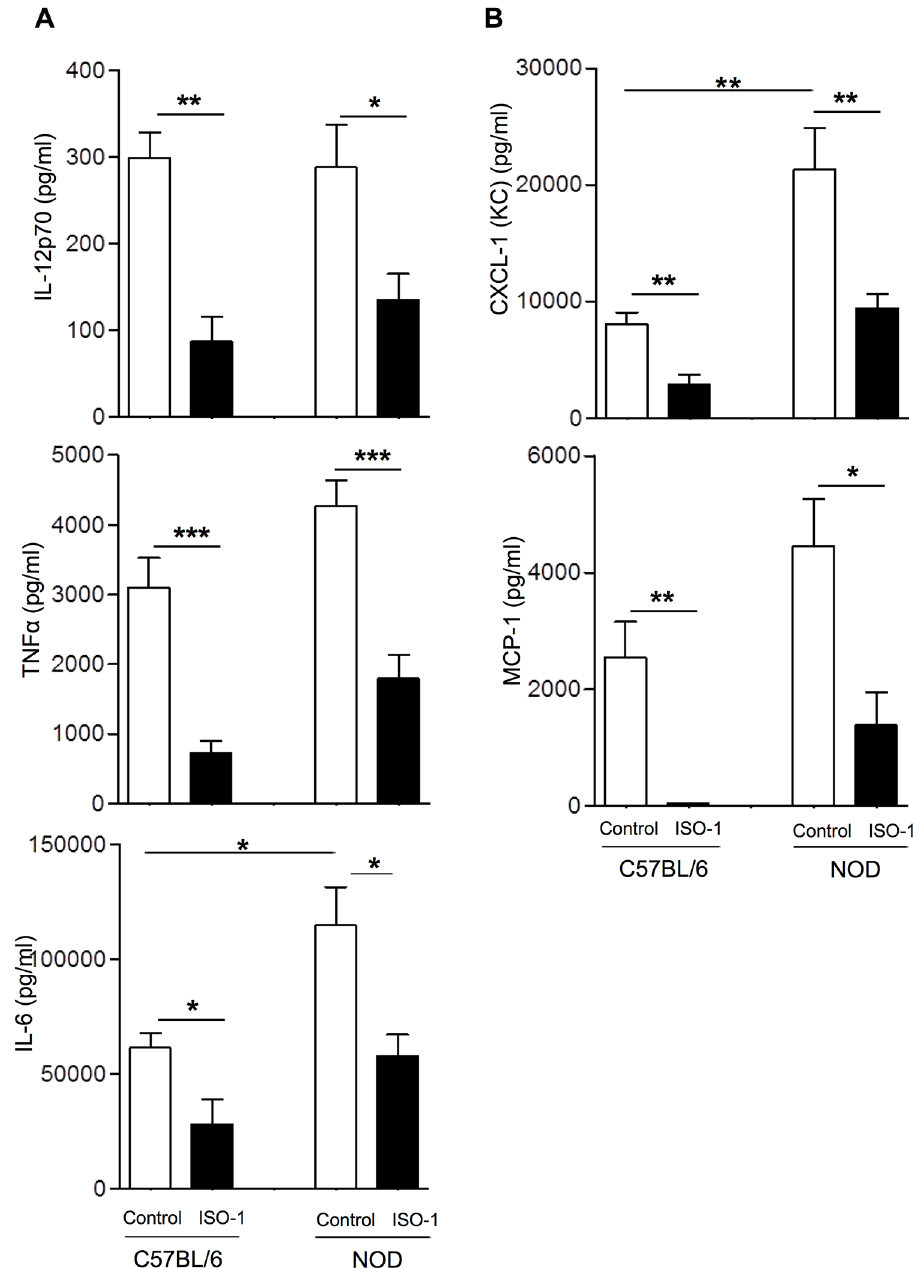
Fig 3. Macrophage preconditioning with ISO-1 curtails their activation-induced cytokine and chemokine production. Peritonealmacrophagesisolated from C57BL/6or NOD mice were purifiedby adherence as describedand preconditioned with or without ISO-1 before exposure to the activationtriggers. Supernatants were harvested24 hours after additionof the activationtrigger before assessment of cytokines (A) and chemokines(B) as indicatedin the materials and methods section. In an unstimulated conditionthe levels of the depictedinflammatory parameters were low to negative(not shown). Data are presentedas the mean ± SEM, (n = 8) ( * , p < 0.05; ** , p < 0.01, *** p < 0.005).